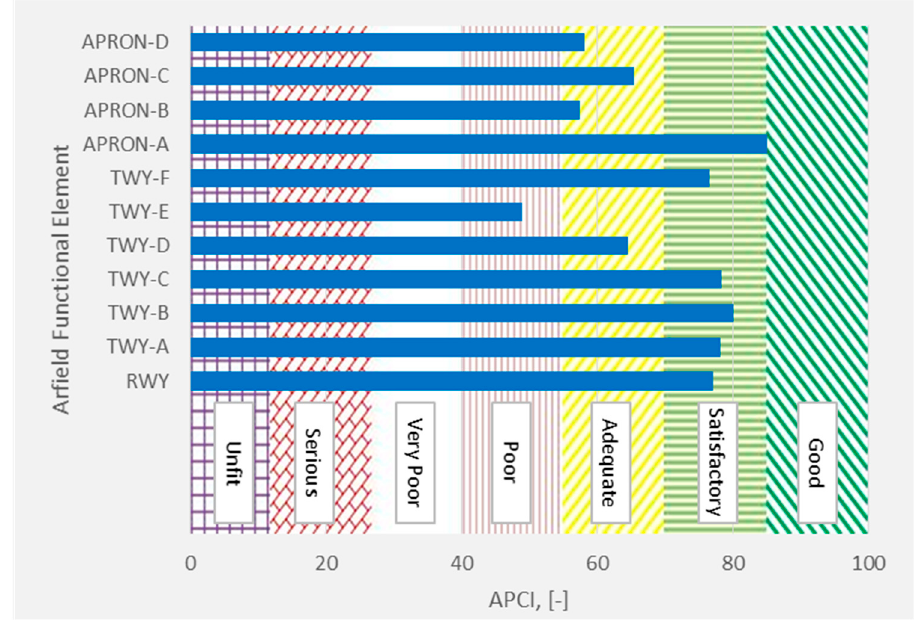
Figure 14. APCI values for individual functional elements of the airport.